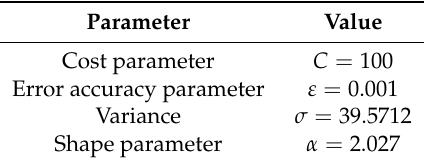
Table 2. Selected parameters.